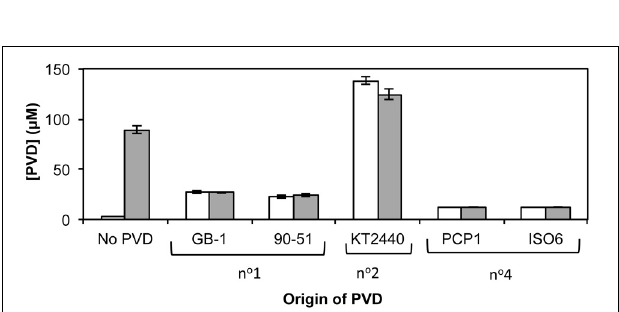
FIGURE 4 | The effect of exogenous PVDs on biofilm formation by P. putida GB-1. Biofilm formation was estimated using crystal violet staining. [Fe(III)] = 2 μ M (added as FeCl 3 ) and [PVD] = 10 μ M (if added). Error bars indicate the standard deviation of measurements of triplicate samples.